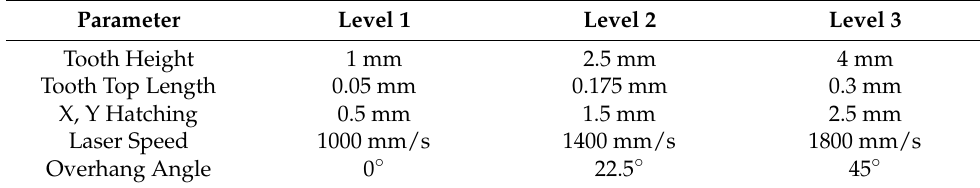
Table 1. Selected support structure parameters and levels.